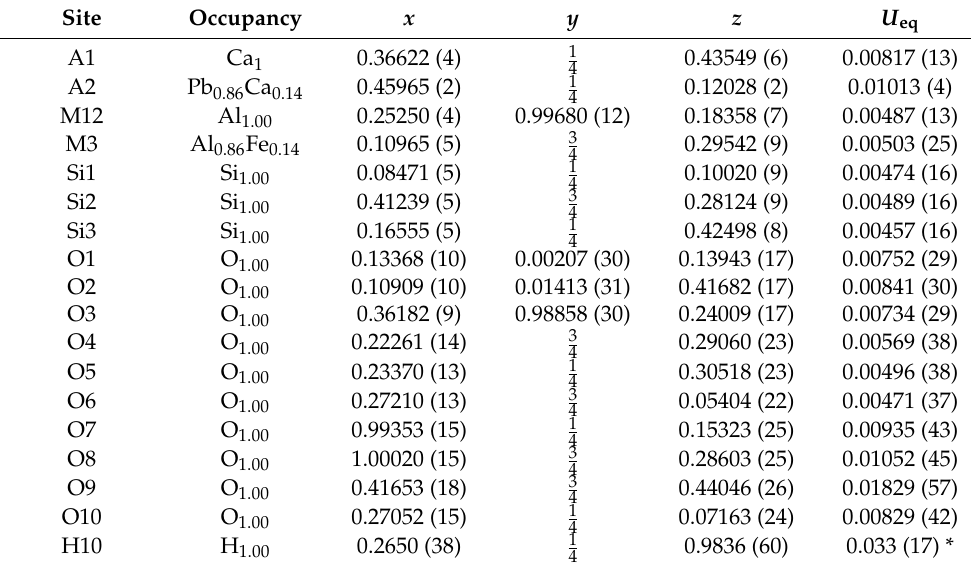
Table 4. Atom coordinates and isotropic displacement parameters (in Å 2 ) for zoisite-(Pb). Refined occupancies for mixed sites A2 and M3 were Pb 0.856(1) + Ca 0.143(1) and Fe 0.864(2) + Al 0.136(2), respectively. * Hydrogen atom H10 was refined isotropically.